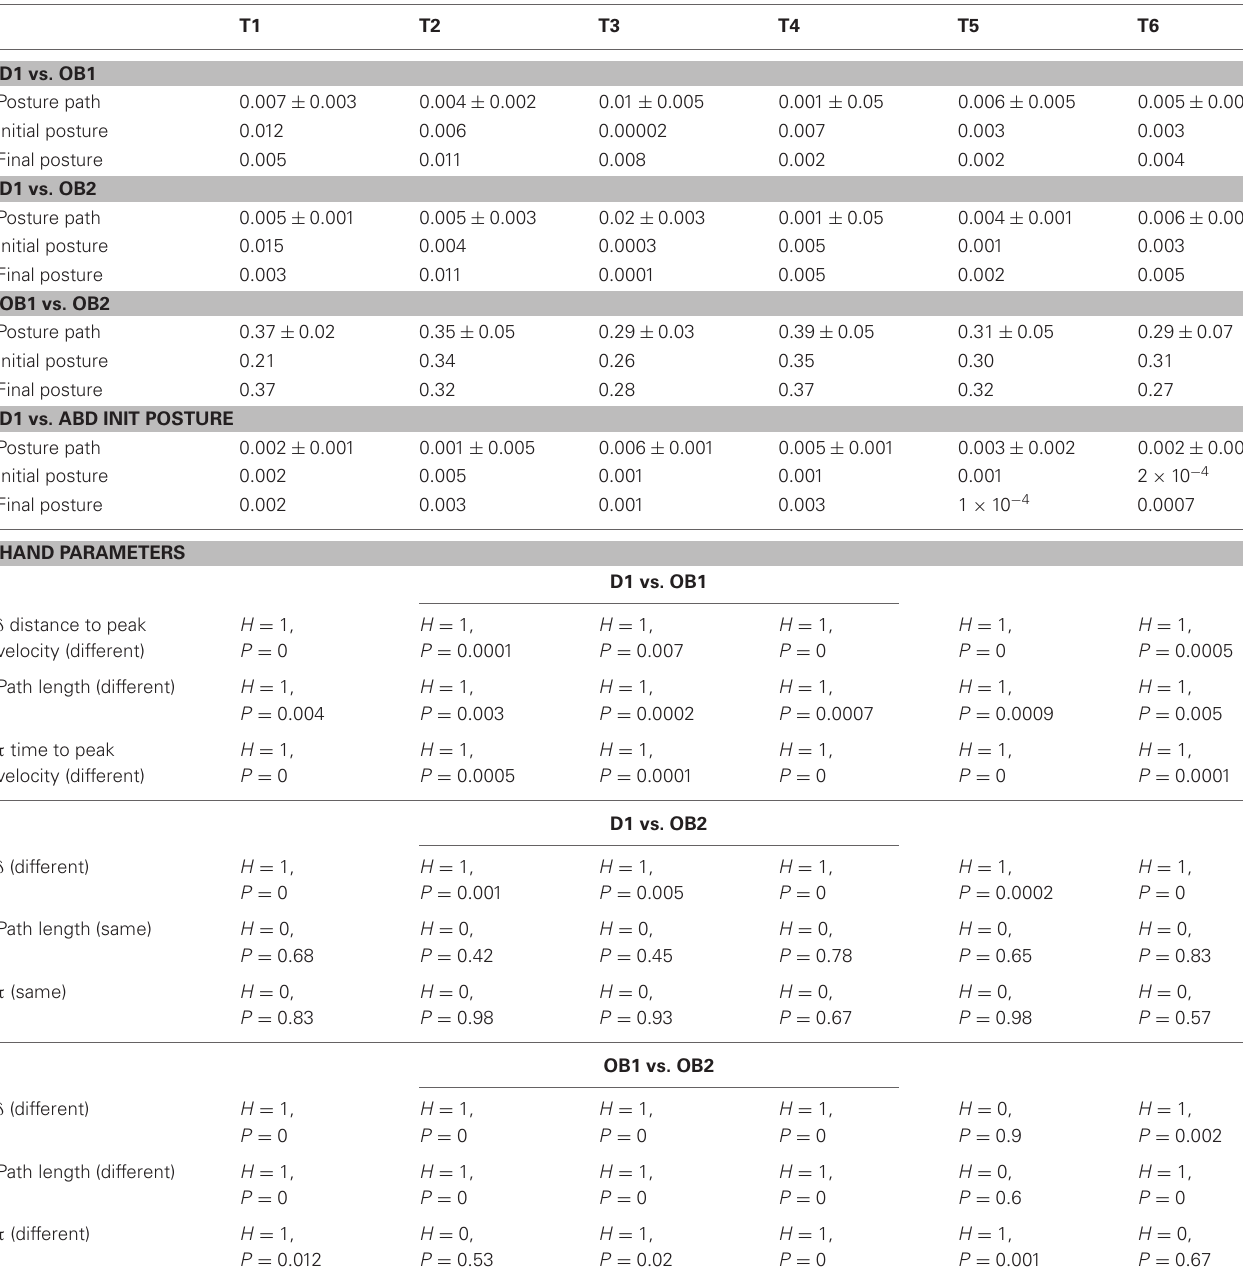
Table 1 | Results of statistical analyses of postural and endpoint